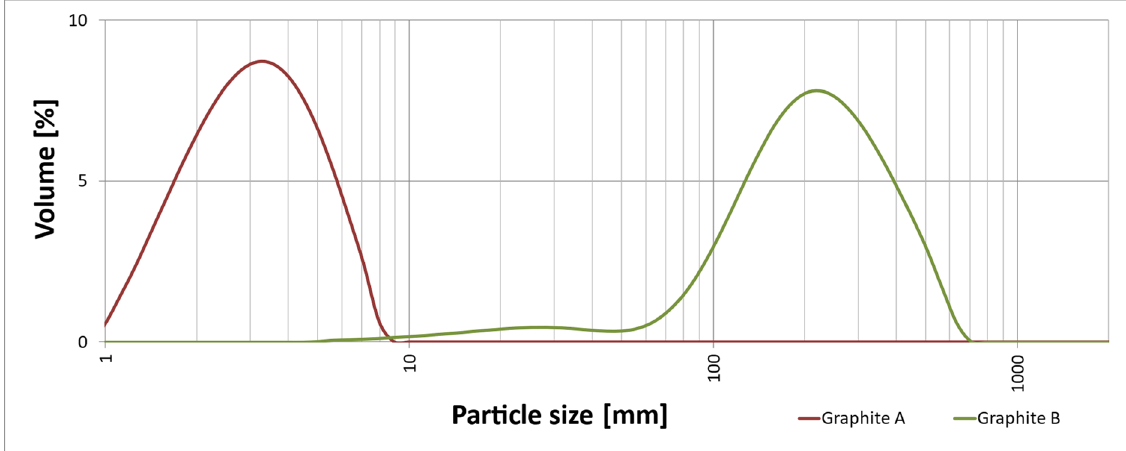
Figure 2. Grain size curves of the graphite powders. Mixture